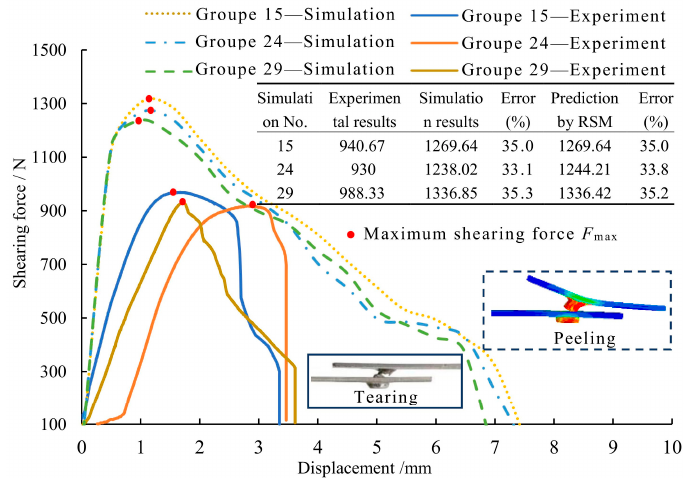
Figure 13. Shearing force-displacement curves of the joint obtained from simulation and experiment.